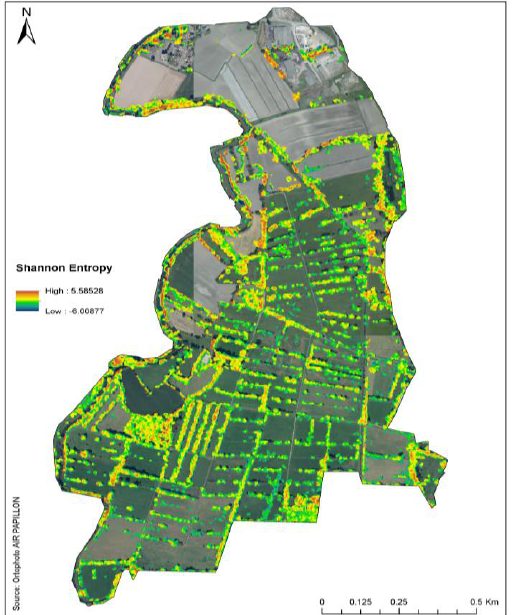
Figure 8. Map of the Shannon entropy index of the hedgerows extracted from the TerraSAR-X image.